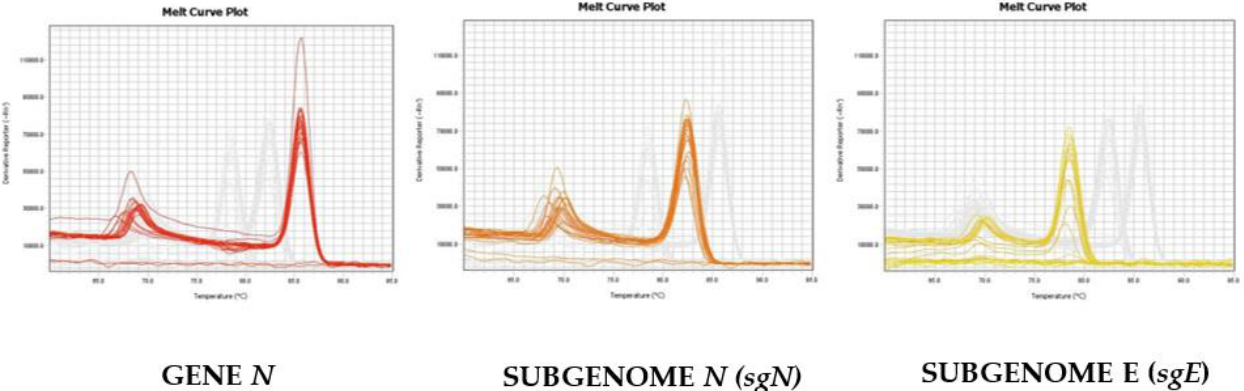
Figure 2. Melting curve profiles obtained by HRMA on the different genomic and subgenomic regions of SARS-CoV-2. The amplification plots of the three targets are clearly shown, as the melting temperatures (Tm) are different: Gene N (Tm = 86.5), sgN (Tm = 82.5), and sgE (78.0), respectively.